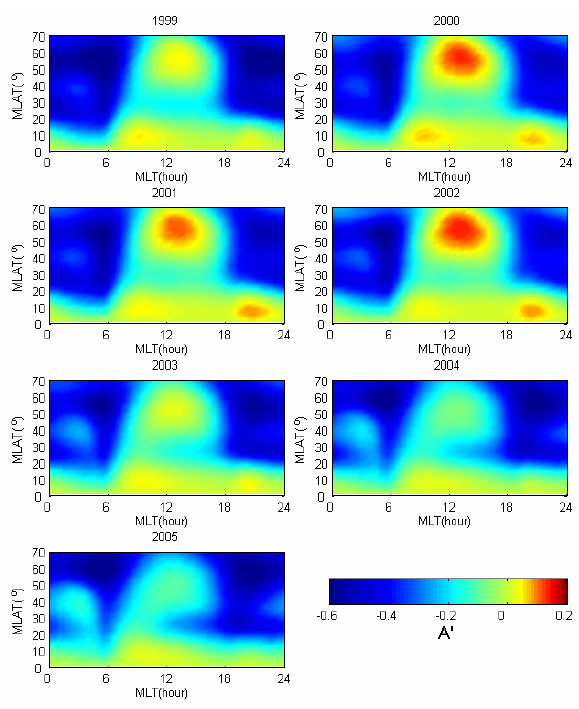
Fig. 3a. Distribution of (a) symmetrical index A 0 , defined as Figure 3. Distribution of (a) symmetrical index A’ defined as ( A 1 (MLAT)- A 1 (-MLAT))/2 (b) asymmetrical index A” defined as ( A 1 (MLAT) − A 1 ( − MLAT))/2 (b) asymmetrical index A 00 , defined ( A 1 (MLAT)+ A 1 (-MLAT))/2 and (c) semiannual component A 2 for the as ( A 1 (MLAT)+ A 1 ( − MLAT))/2 and (c) semiannual component A 2 year 1999-2005. for the year 1999–2005.